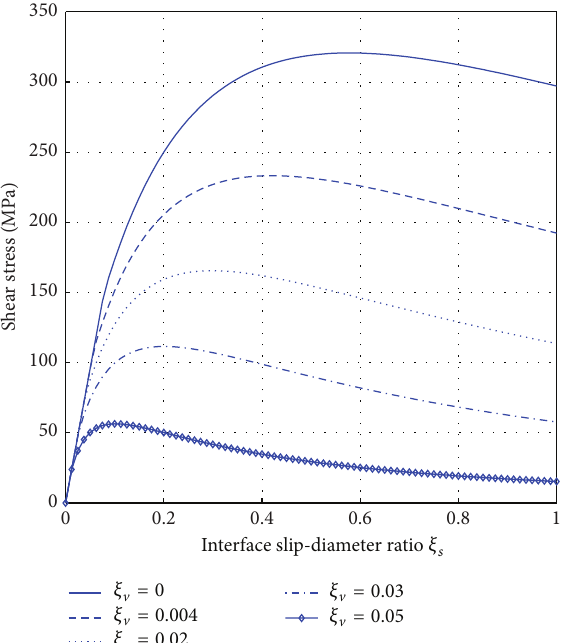
Figure 7: The curve of 𝜉 𝑠 to shear stress of single steel bar with different 𝜉 V .